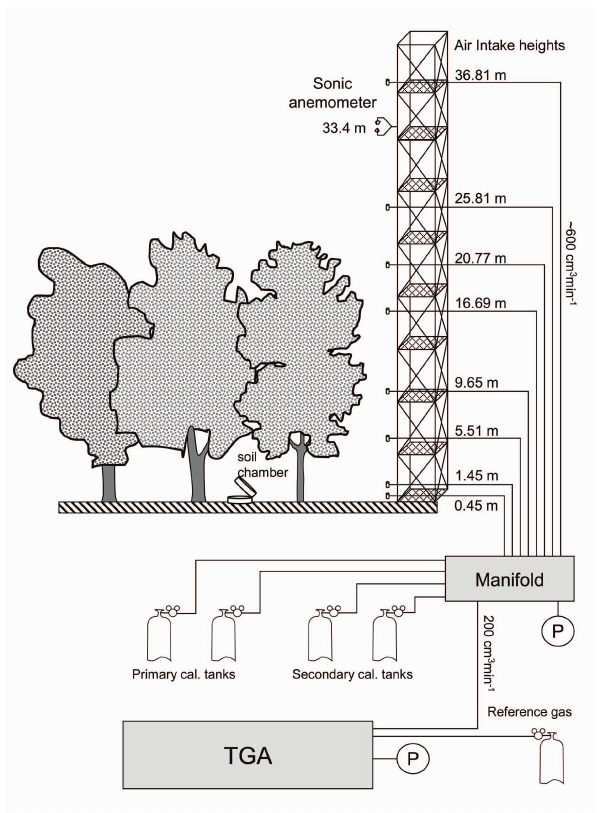
Fig. 1. Experimental setup used to study C 16 O 2 and C 18 OO ex- change in a temperate deciduous forest in Borden, ON, Canada. TGA denotes tunable diode laser; P shows placement of vacuum pumps. Placements of the automatic soil chamber used to measure the soil CO 2 flux and sonic anemometer are also